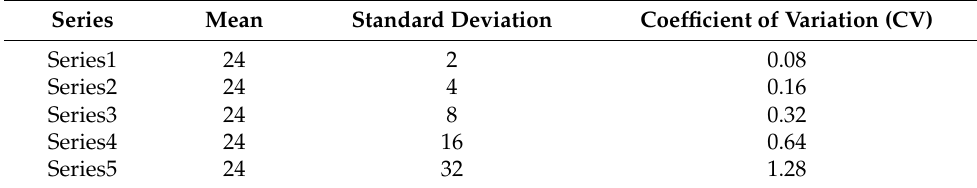
Figure 6. Normal distribution curves drawn for different values of CV. Table 1. Value of Mean, Standard Deviation and Coefficient of Variation (CV) for different